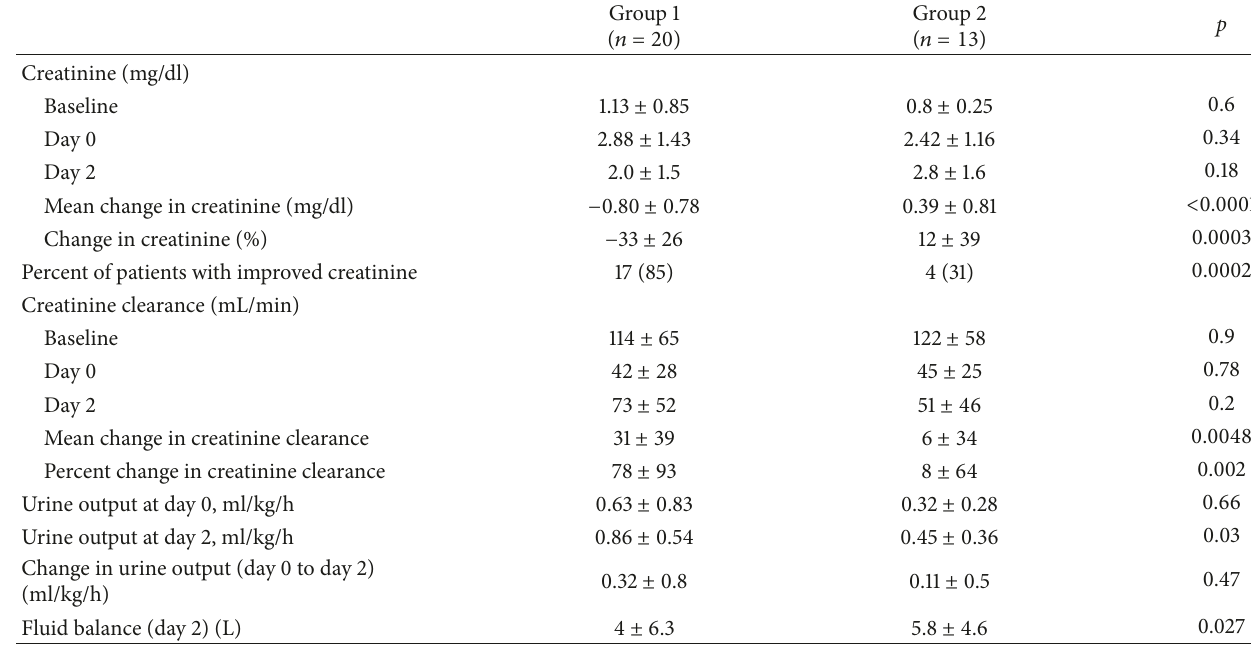
Table 4: Renal function at baseline, day 0, and day 2 in the 33